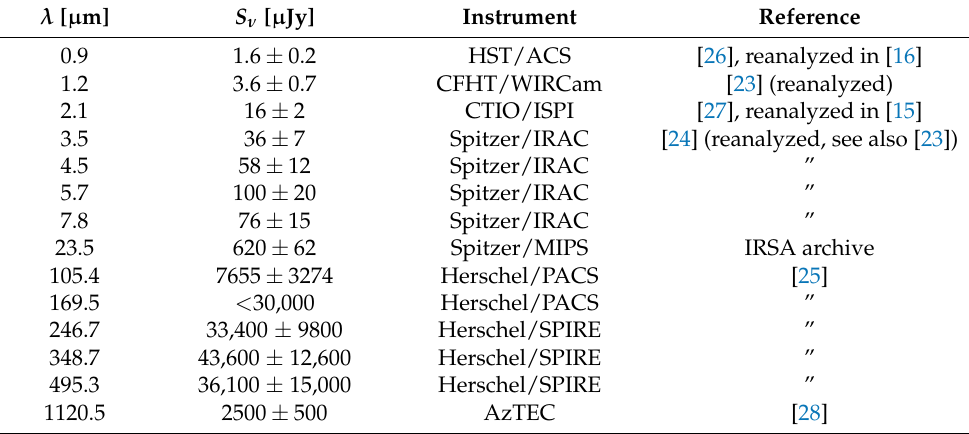
Table 1. Photometric data-points used to perform the SED fitting. Column 1: observing wavelength. Column 2: observed flux density. Column 3: observing instrument. Column 4: archive references, where we specify whether the data have been